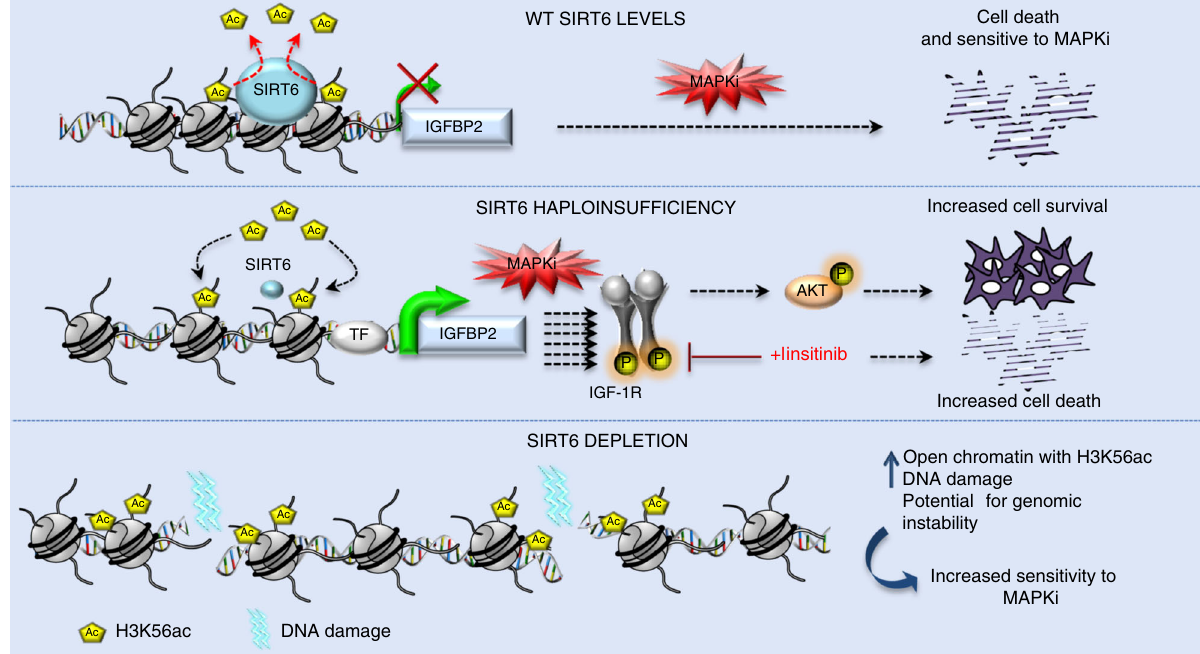
Fig. 6 Model: SIRT6 levels regulate resistance or sensitivity to MAPKi. (Top) Under baseline conditions, SIRT6 deacetylates H3K56ac at the IGFBP2 locus to maintain low expression levels and low IGF-1R/AKT pathway signaling, impairing cell survival in the presence of MAPKi. (Middle) In the context of SIRT6 haploinsuf fi ciency, IGFBP2 expression is enhanced via increased chromatin accessibility and H3K56 acetylation at the IGFBP2 locus. Activation of the IGF-1 receptor (IGF-1R) and downstream AKT signaling allows melanoma cells to persist in the presence of MAPKi. (Bottom) SIRT6 depletion triggers signi fi cant chromatin reorganization re fl ected by increased open chromatin and H3K56ac at these sites, coupled to DNA damage accumulation. This potential for genomic instability increases the sensitivity to